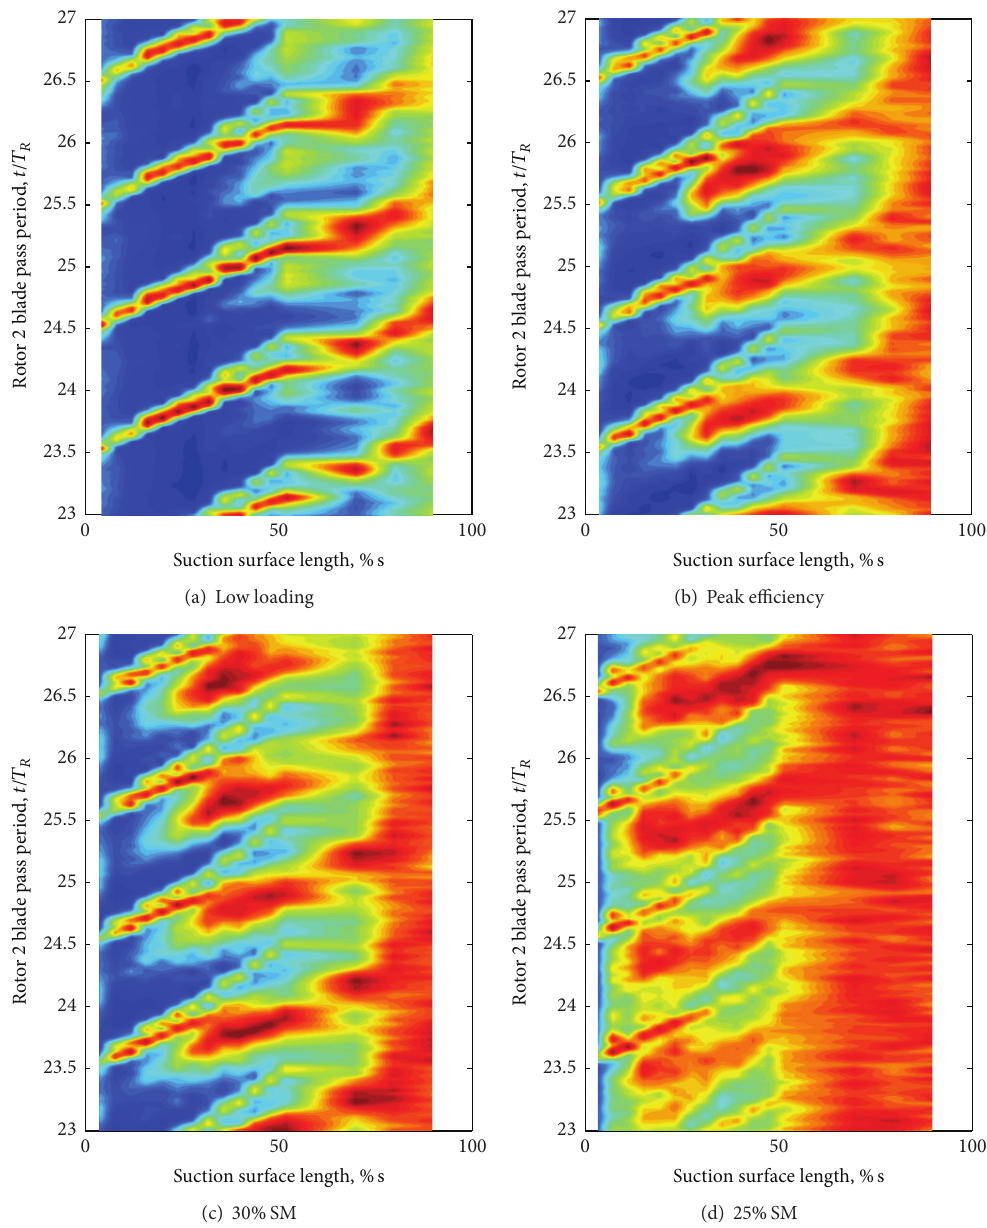
Figure 6: QWSS RMS for mid-span Stator 2 at four loading